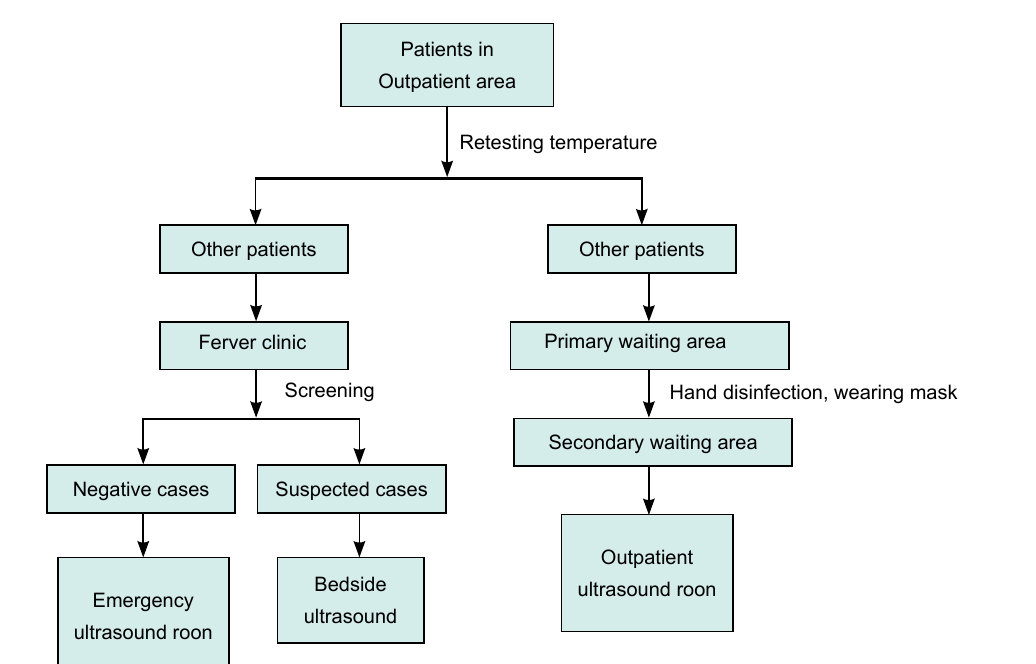
Figure 1 Examination flow of patients in outpatient area of ultrasound